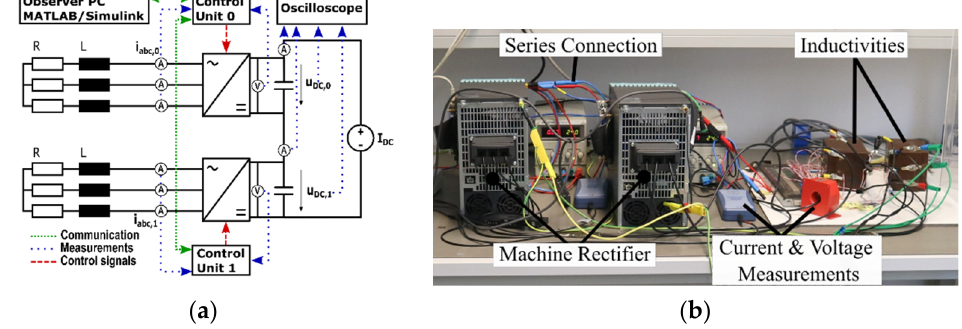
Figure 4. ( a ) Schematic of the laboratory test setup; ( b ) Picture of the laboratory test setup. The current source feeds a constant current while the machine rectifiers maintain a constant voltage across the DC-cascade. The rectifier control unit measures the stator current i abc , i and the DC voltage u DC, i , which are used for the control and recorded for the analysis. For further analysis, an oscilloscope also measures the DC currents i DC, i and the DC voltages (cid:1873) (cid:3005)(cid:3004),(cid:3036) . The control, DC-cascade configuration and the dynamic behavior were tested at different operating points. Figure 5 shows a voltage setpoint step from (cid:1873) (cid:3005)(cid:3004),(cid:3036)∗ = 200 V to (cid:1873) (cid:3005)(cid:3004),(cid:3036)∗ = 300 V . Figure 5a displays the values recorded by the control unit. Figure